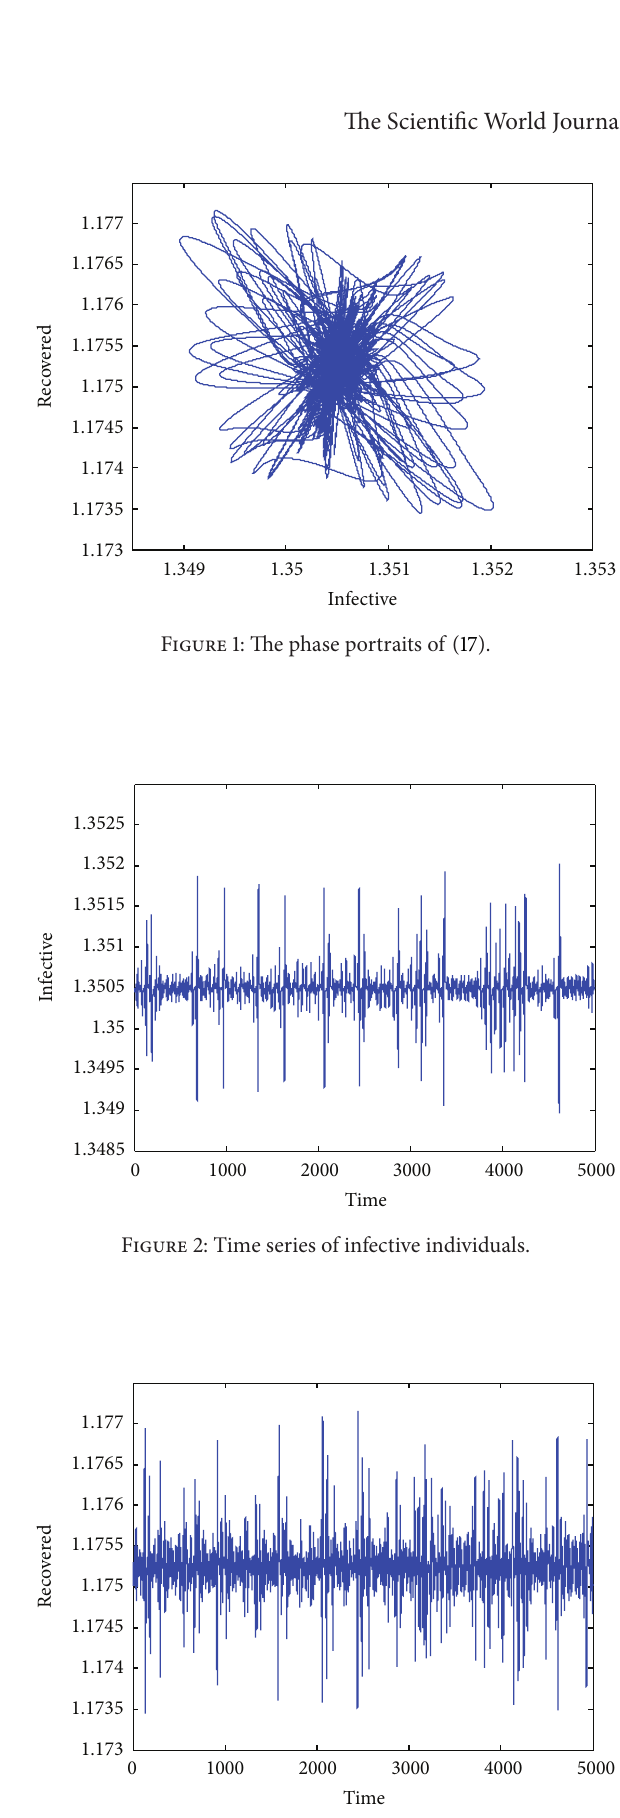
Figure 3: Time series of recovered